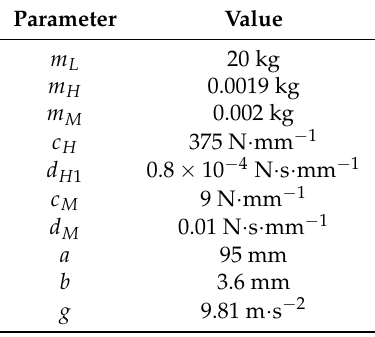
Table 4. Experimental parameters for the hydraulic engine mount system model [27].